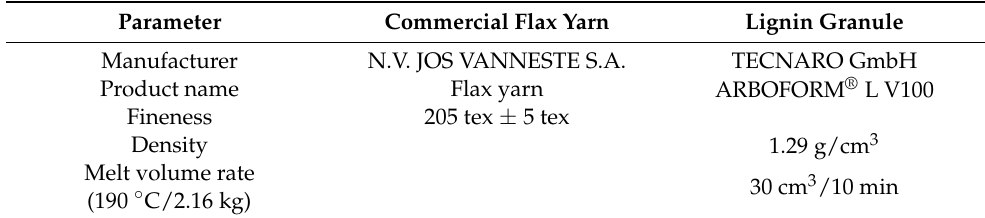
Table 1. Materials